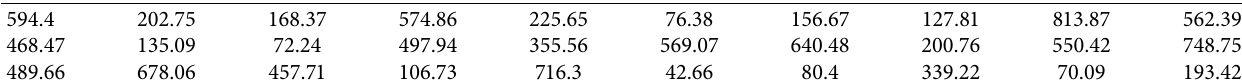
Table 7: Data set 2 (15